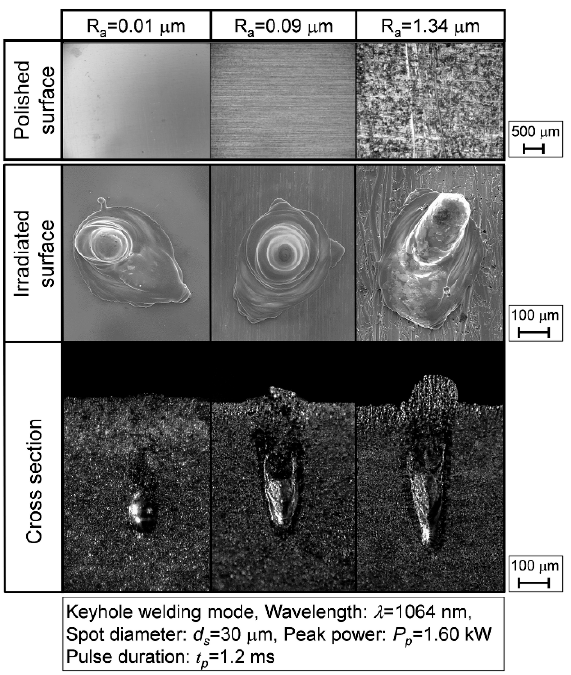
Figure 10. Observed surfaces and cross-sections for different surface roughness values.